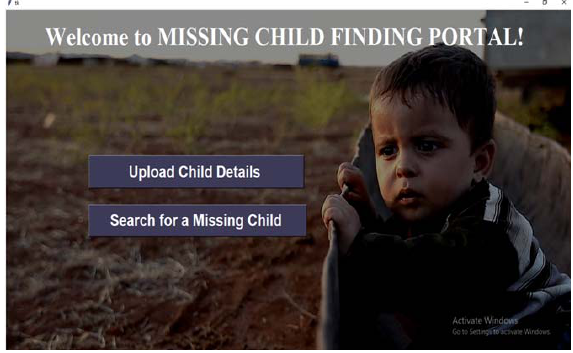
Figure 7. Welcome page of a missing child finding portal.